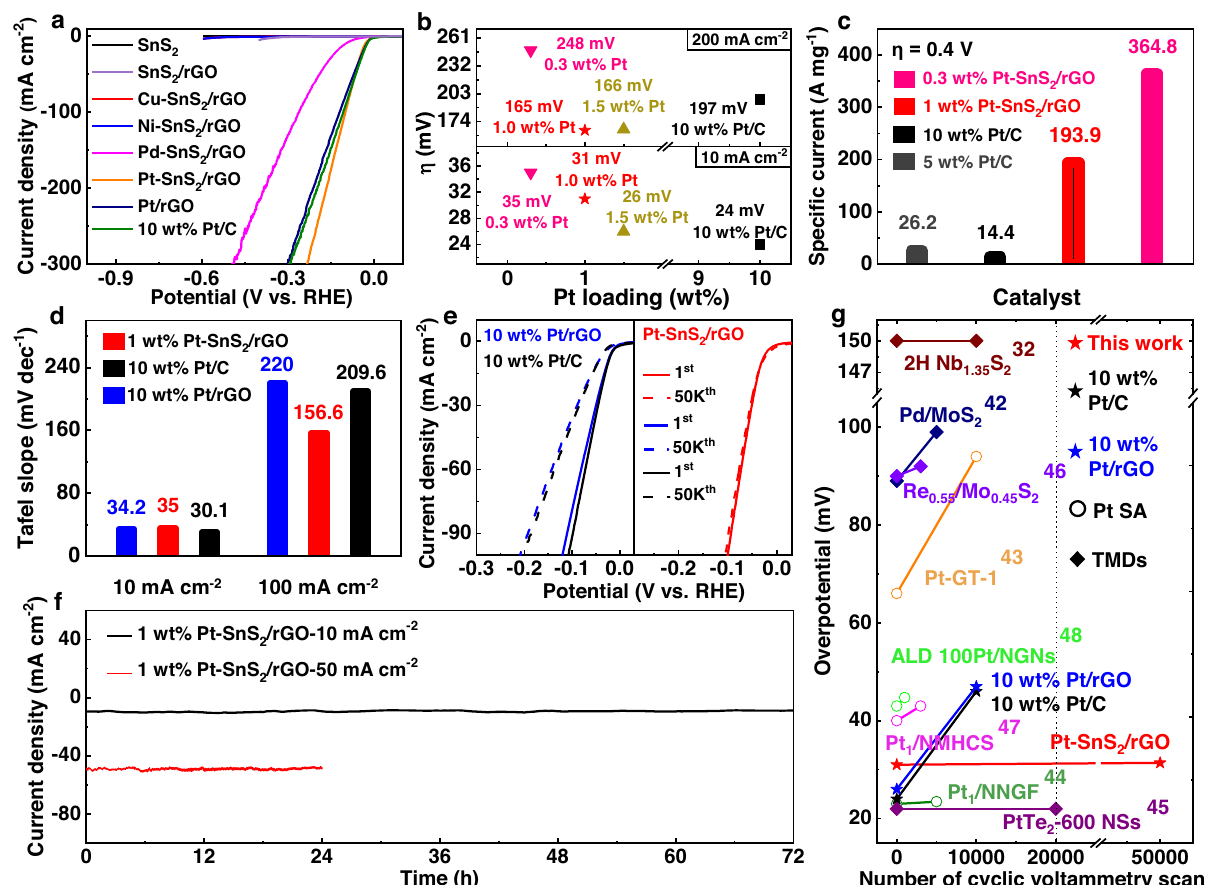
e Polarizationcurvesof1wt%Pt-SnS 2 /rGO,10wt%Pt/rGO,and10wt% Pt/Cbefore andaftercatalytictestingcycles. f Currentdensityversustime (i – t)curveof1wt% Pt-SnS 2 /rGO recorded for 72h and 24h at a constant overpotential of 50mV and 88mV vs RHE, respectively. g Comparison of the overpotential increase after a certainnumberofcyclicvoltammetryscansbetweenour1wt%Pt-SnS 2 /rGO,10wt % Pt/rGO, 10wt% Pt/C, other Pt single-atom catalysts, and 2D transition metal dichalcogenides (TMDs) reported in